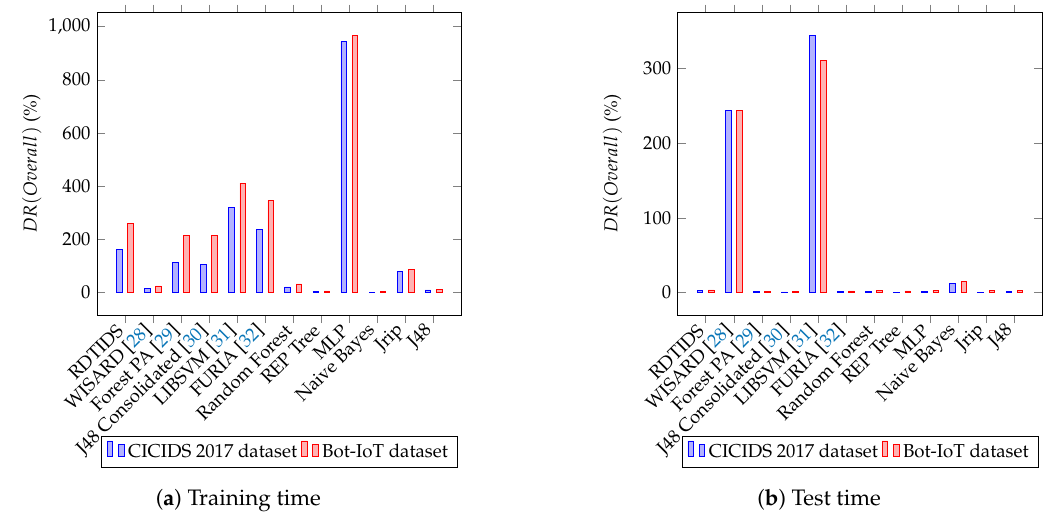
Figure 6. Overall Performance of RDTIDS and other classifiers in terms of training and test